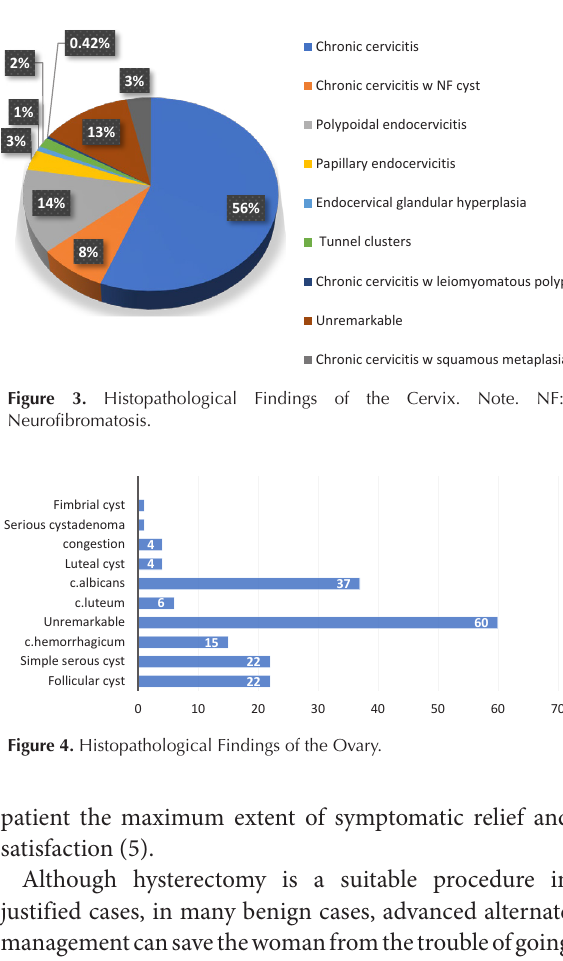
Figure 2. Histopathological Findings of the Myometrium. Note. UR: Unremarkable; DUB: Dysfunctional uterine bleeding.